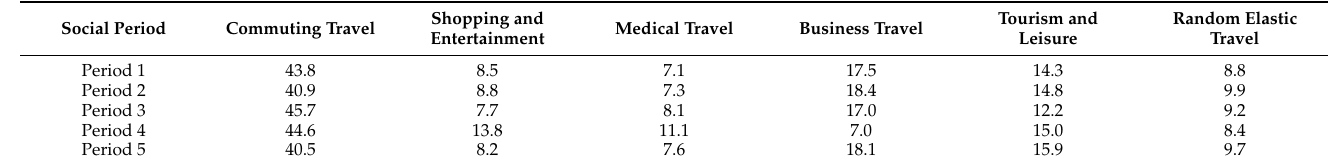
Table 2. The proportions of residential travel with different purposes over different periods.